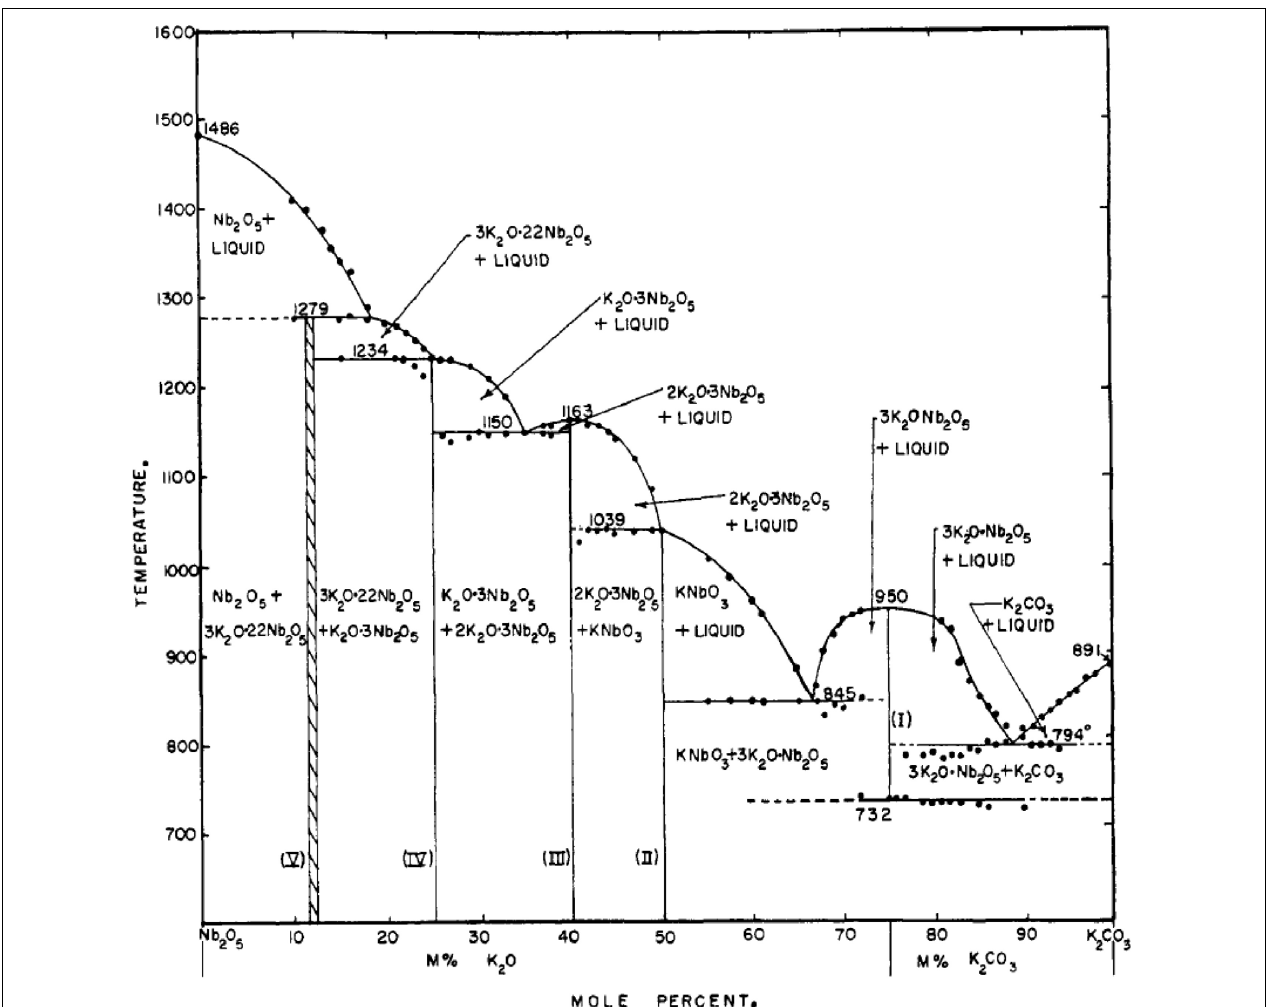
FIGURE 5 | Phase diagram for the Nb 2 O 5 -K 2 CO 3 system. [Adapted with permission from J. Am. Chem. Soc. 1955, 77, 8, 2115–2119 (Reisman and Holtzberg, 1955), American Chemical Society,